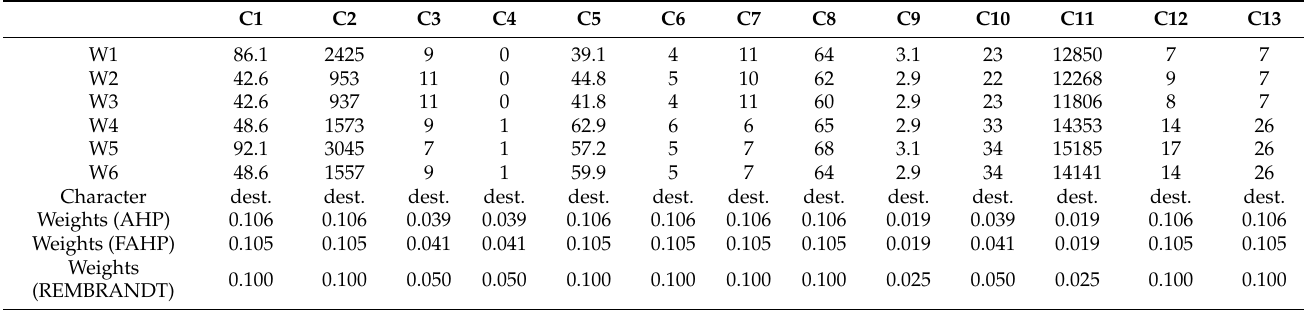
Table 11. Initial data (VIKOR method).